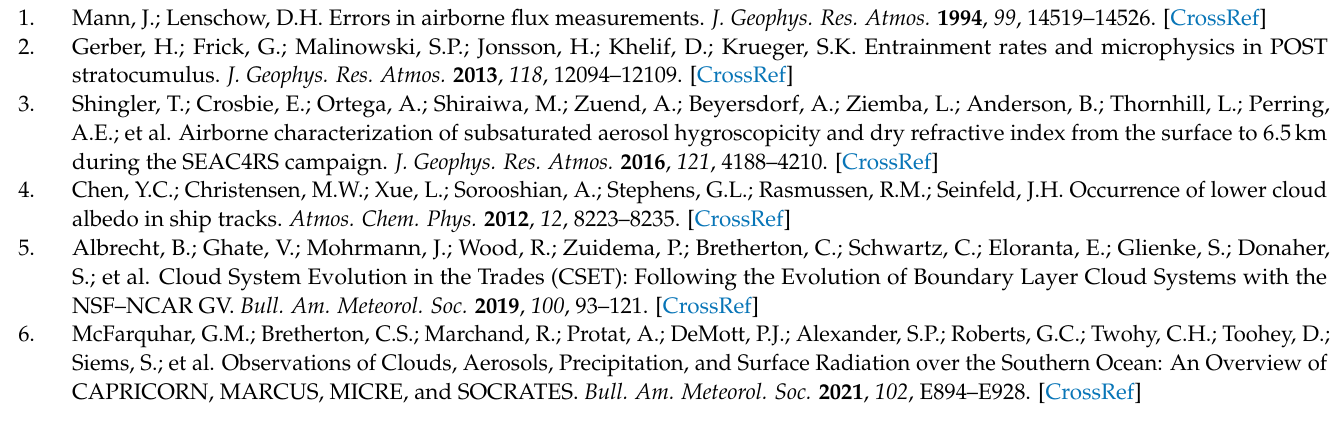
Scatterplots of leg-mean values for selected variables measured in BBL and Min. Alt. legs in clear ensembles during 2019 MONARC flights. The plots on the sides are marginal distri-butions based on Kernel density estimation. Figure S2. Scatterplots of leg-mean values for selected variables measured in BBL and Min. Alt. legs in clear ensembles during 2020 ACTIVATE flights. The plots on the sides are marginal distri-butions based on Kernel density estimation. Figure S3. Example of removing the linear trend across an individual level leg. (a) Raw data for potential temperature for the Min. Alt. let in ACTIVATE research flight 4 on 21 February 2020 between UTC 19:14:58 and 19:18:17. (b) Detrended data for the same Min. Alt. leg. Figure S4. Comparison between two consecutive BCB legs for selected variables measured in cloud ensembles during 2020 ACTIVATE flights. Markers represent leg-mean